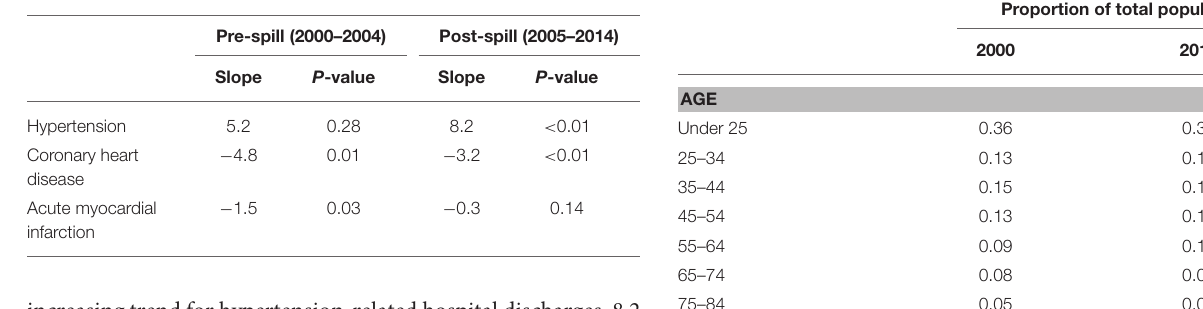
TABLE 3 | Results of the linear regression analyses for annual rates of cardiovascular hospitalizations by diagnosis for the years leading up to the chlorine spill (2000–2004) and the years following the spill (2005–2014).